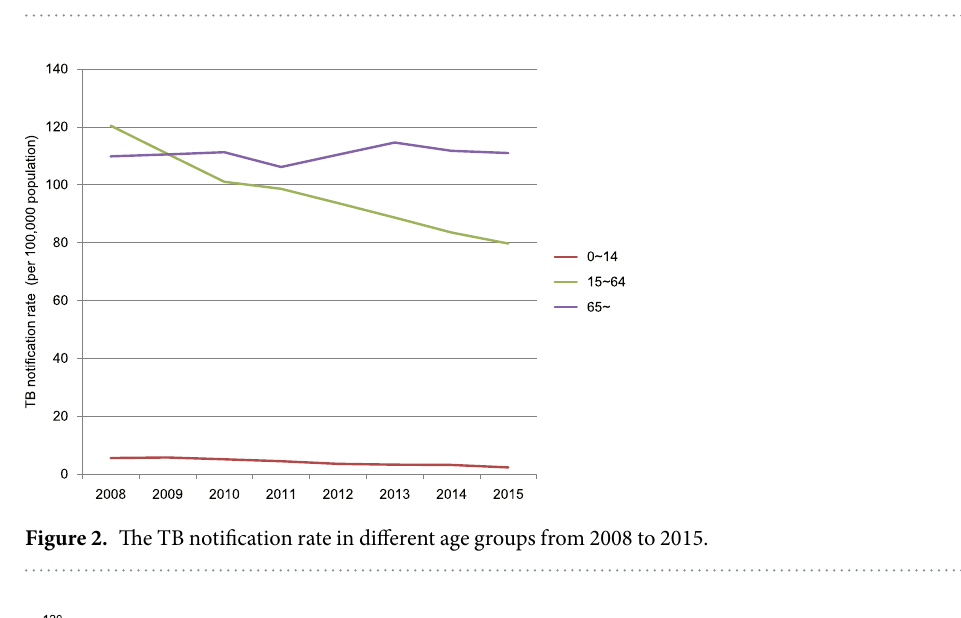
Figure 1. The trend of TB notification rate from 1992 to 2015. The TB notification rate of total notified and smear-positive patients was shown. Total notified TB patients included all forms of TB. Smear-positive TB patients included the new and retreatment patients.